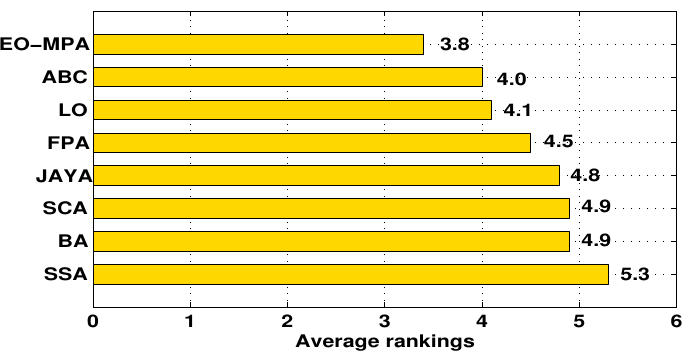
Figure 10. Average rankings of all comparative methods on all test functions.